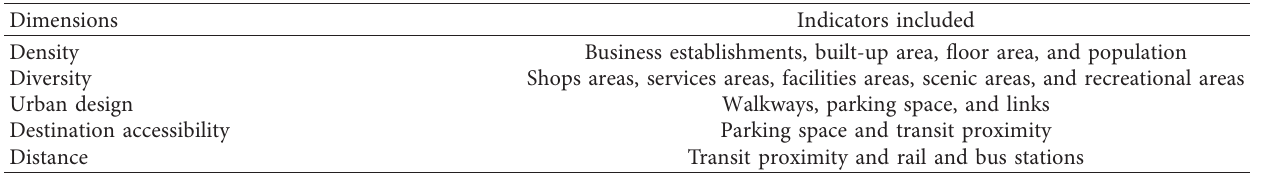
Table 2: Overview in TOD-related indicators